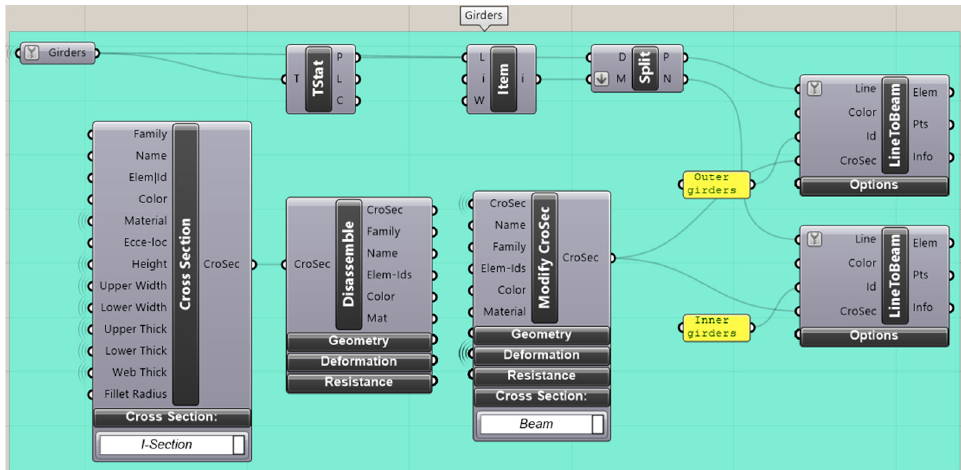
Figure 10. Girders development using Karamba 3D in Grasshopper.